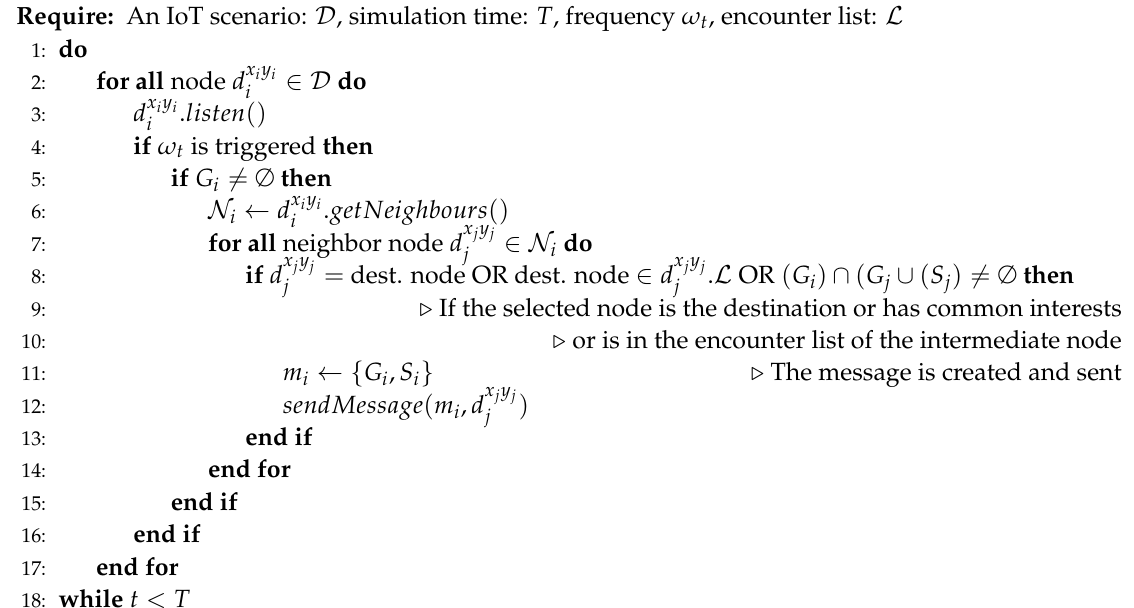
Algorithm 6 SACAR-Hybrid